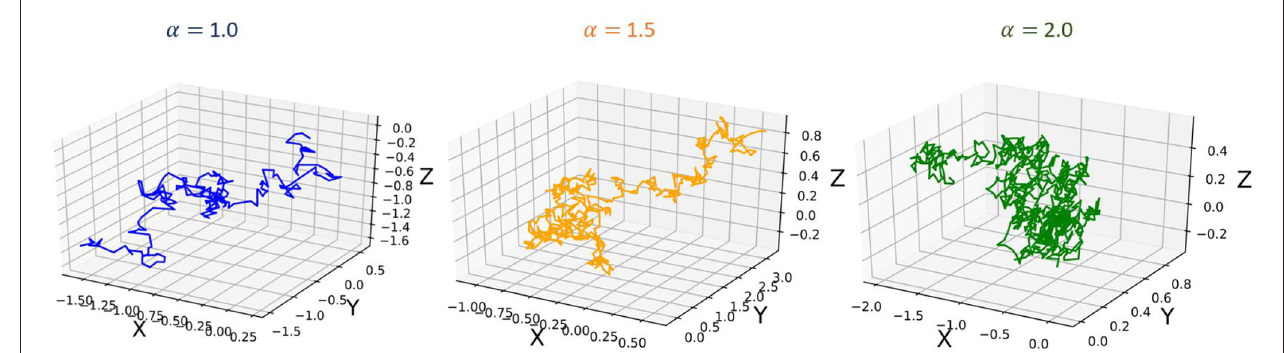
FIGURE 2 | Plot showing the trajectories of the α